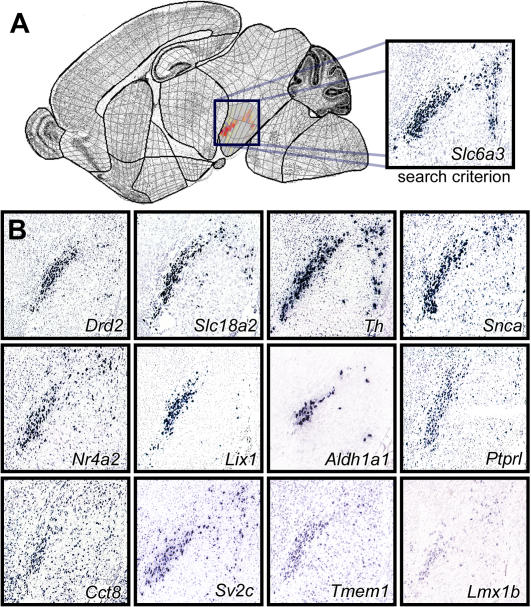
A Search for Genes that Are Expressed in the Substantia Nigra(A) The pattern of Slc6a3 gene expression in and around the substantia nigra at standard section number 6 is set as the query pattern for a search of all 200 expression patterns in the current dataset. Note the color-coded shading of the query pattern, with red indicating the strong expression of Slc6a3 in the substantia nigra, and grey indicating no expression in the tissue surrounding the substantia nigra.(B) The expression patterns in the substantia nigra pars compacta of the 12 genes found to match the search criterion best are shown: dopamine receptor 2 (Drd2); vesicular monoamine transporter 2 (Slc18a2); tyrosine hydroxylase (Th); alpha synuclein (Snca); a gene encoding a nuclear orphan receptor (Nr4a2); limb expression 1 homolog (Lix1); a gene encoding an aldehyde dehydrogenase (Aldh1a1); protein tyrosine phosphatase, receptor type L (Ptprl); chaperonin subunit 8 (Cct8); synaptic vesicle glycoprotein 2c (Sv2c); transmembrane protein 1 (Tmem1); and LIM homeobox transcription factor 1 beta (Lmx1b).